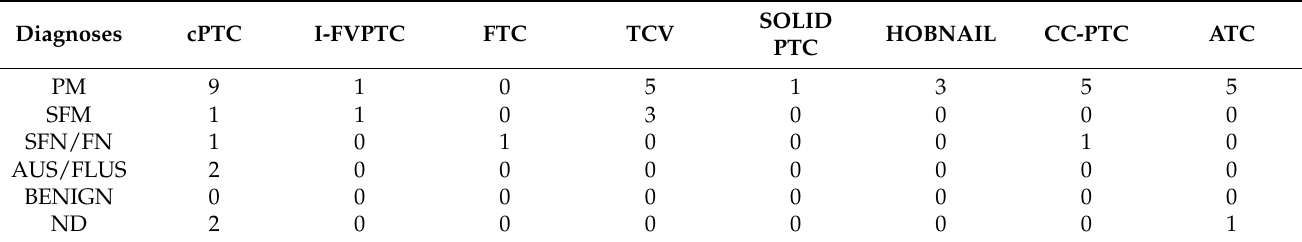
Figure 1. Distribution of thyroid cancer histotypes and multifocality; legend: PTC: papillary thyroid carcinoma; FC: follicular carcinoma; FVPTC: follicular variant of PTC; TCV: tall cell variant of PTC. Table 3. Cyto-histological correlation.